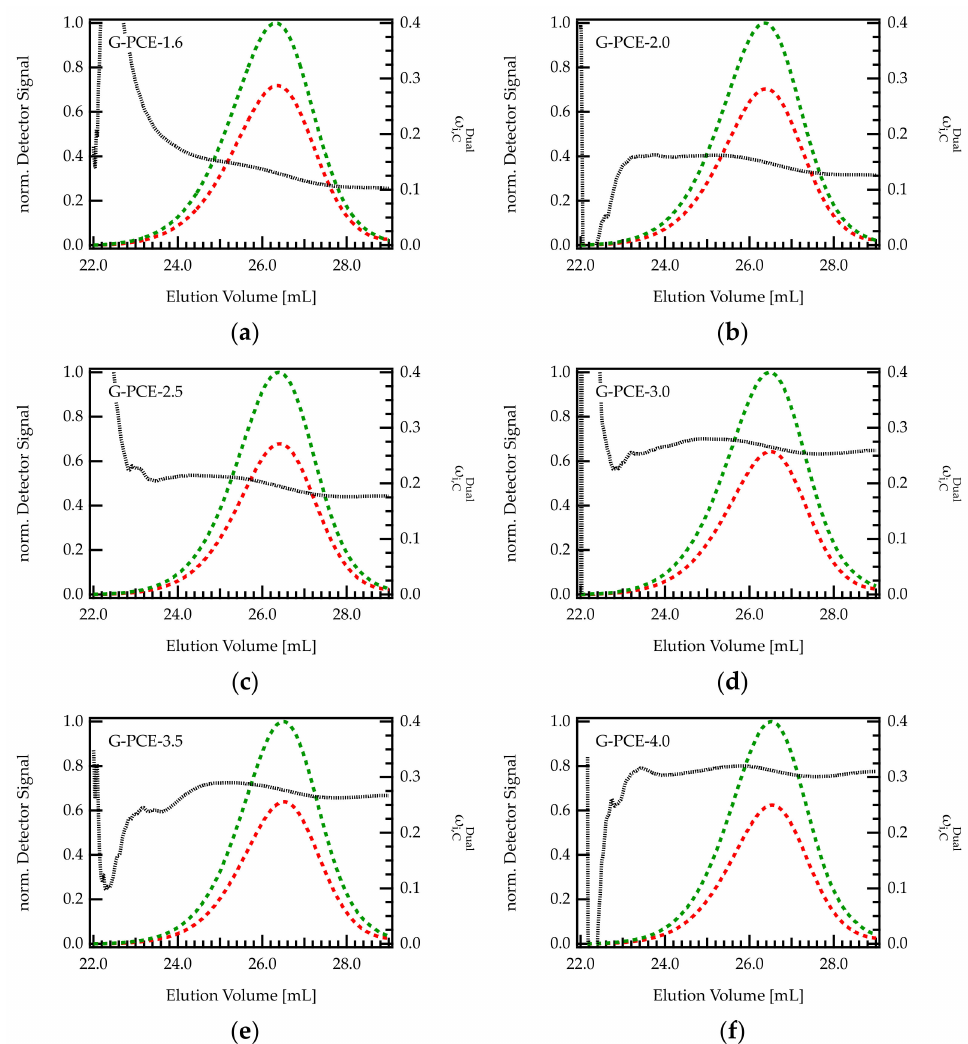
Figure 5. ( a – f ) Chromatograms of various G-PCE samples with different C/E ratios. The green curve is the UV signal, and the red curve corresponds to the RI signal. The signals were normalized with regard to the maximum of the UV peak. The dashed black line indicates the composition of the eluting species monitored by dual detection.